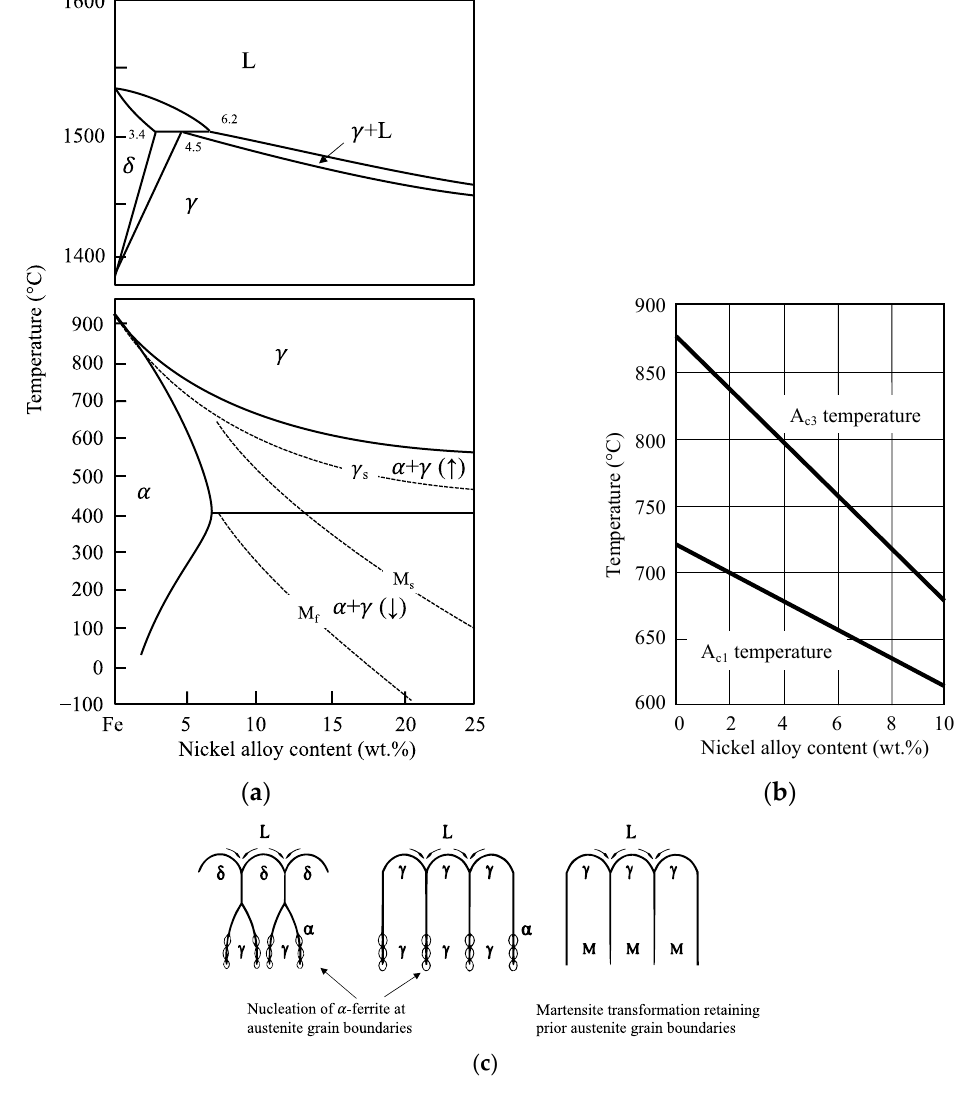
Figure 1. ( a ) Phase diagram of binary Fe–Ni alloy (Composed from data in [7–9]); ( b ) influence of nickel alloying on the transformation temperature of 0.1 wt.% carbon steel upon re-austenitizing using data from [4]; ( c ) solidification scenarios for carbon steels with increasing nickel content (Reprinted from Ref. [6]).